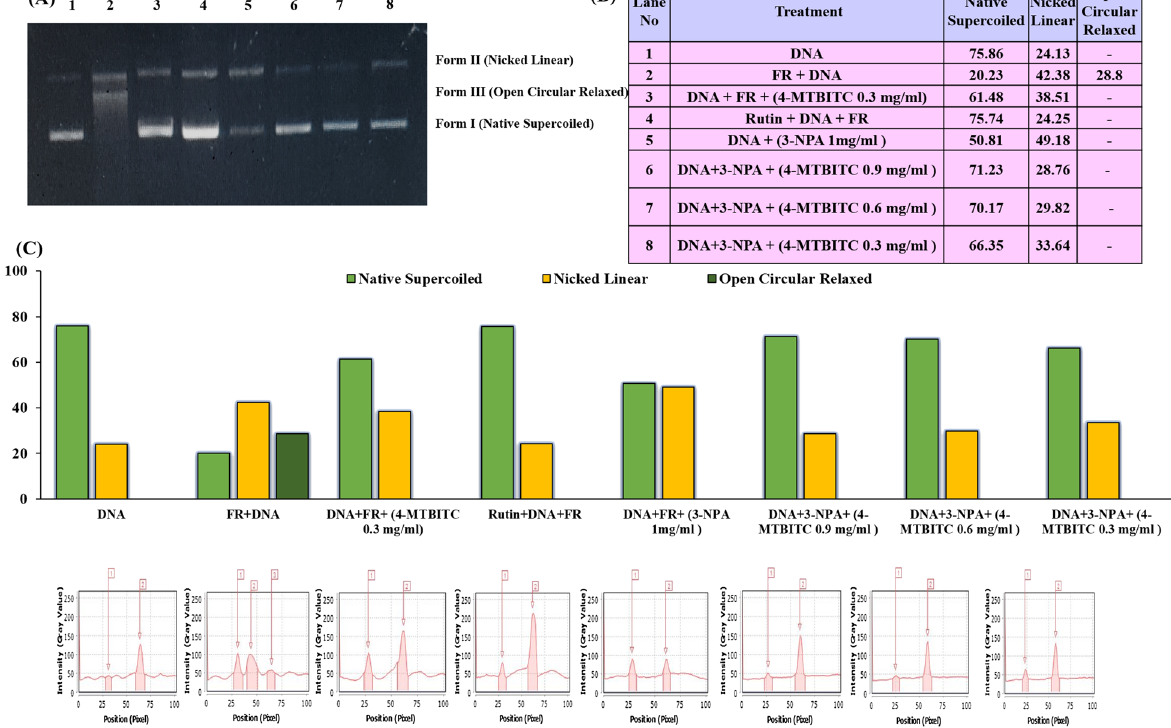
Figure 2. ( A ) Protective effect of 4-MTBITC on pBR322 DNA damage triggered by Fenton’s reagent (FR) and 3-NPA. Lane 1, native supercoiled DNA; Lane 2, FR treated DNA; Lane 3, FR treated DNA + 0.3 mg/ ml 4-MTBITC; lane 4, FR treated DNA and rutin (100 μg/ml); lane 5, DNA + 3-NPA (1 mg/ml); lanes 6–8, 3-NPA treated DNA with varying concentrations (0.3, 0.6 and 0.9 mg/ml) of 4-MTBITC; ( B ) Tabular; and ( C ) Graphical representation of quantitative proportion of different DNA plasmid forms after treatment. All the treatments in each lane of gel were run in parallel. The supplementary file is provided with the raw full-length gel corresponding to figure number used here in the